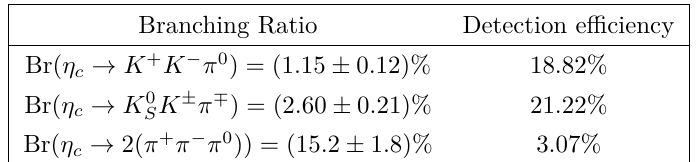
Table 1 . The branching fractions of η c decay modes with corresponding efficiencies.